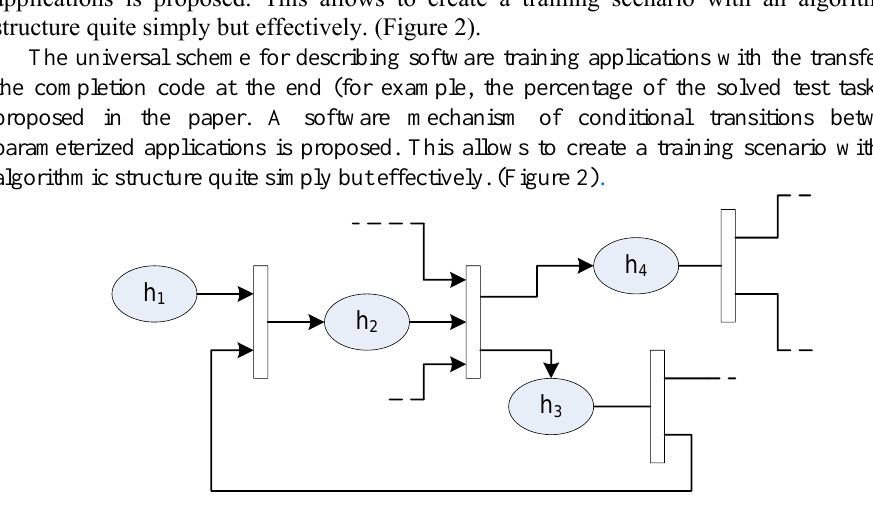
Fig. 2. Algorithmic structure of applications.